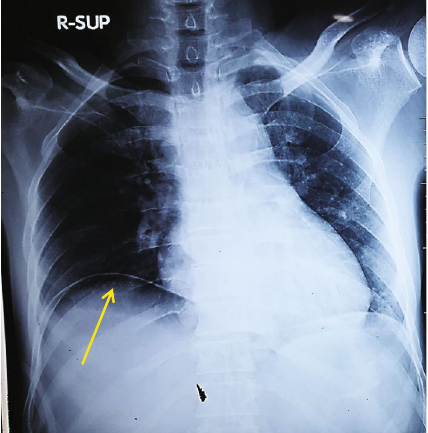
Figure 1: Chest X-ray: yellow arrow shows gas under the right hemidiaphragm.